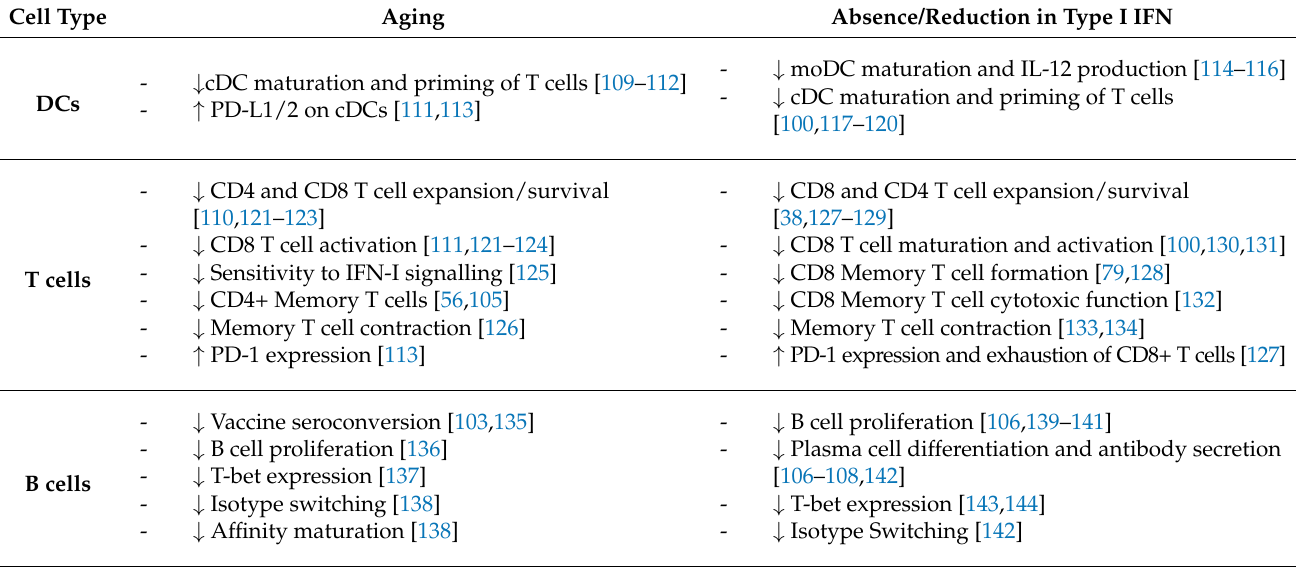
Table 2. Comparison of changes in adaptive immunity in aging and the absence of type I IFN. Cell